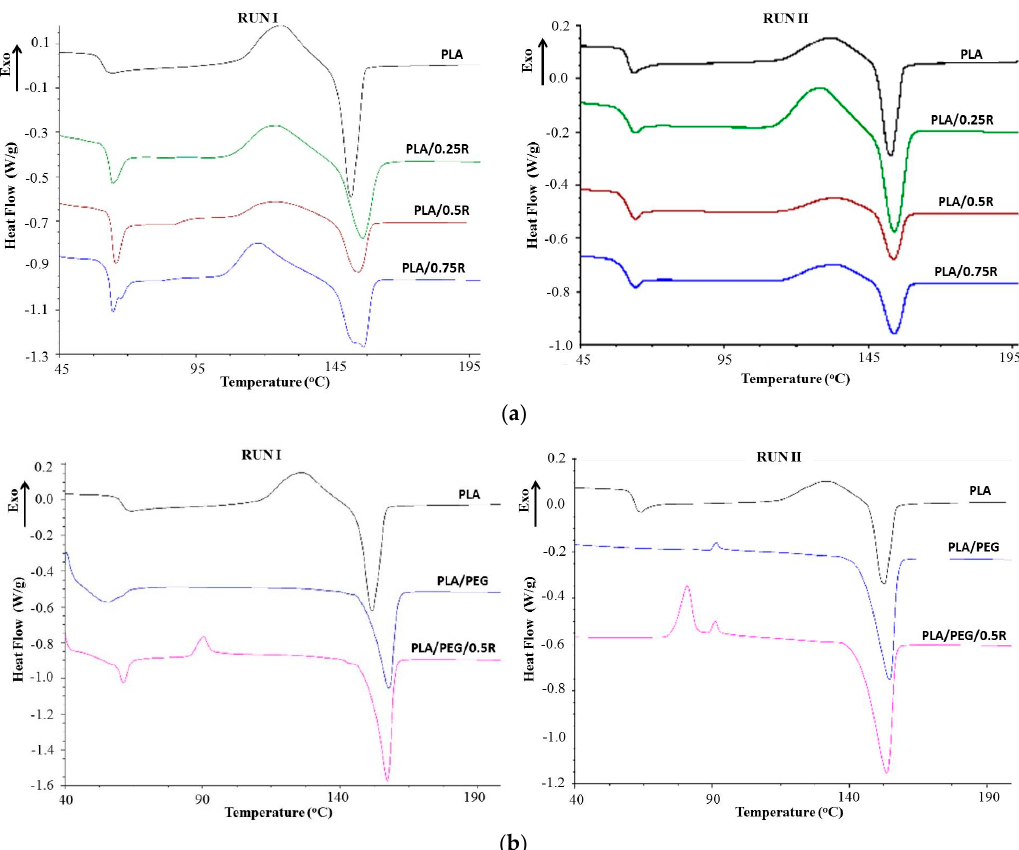
Figure 8. Differential scanning calorimetry (DSC) curves of the PLA and PLA/R ( a ) and plasticized PLA/R systems ( b ). Table 5. Thermal characteristics of the PLA/R and plasticized PLA/R systems determined by DSC method.